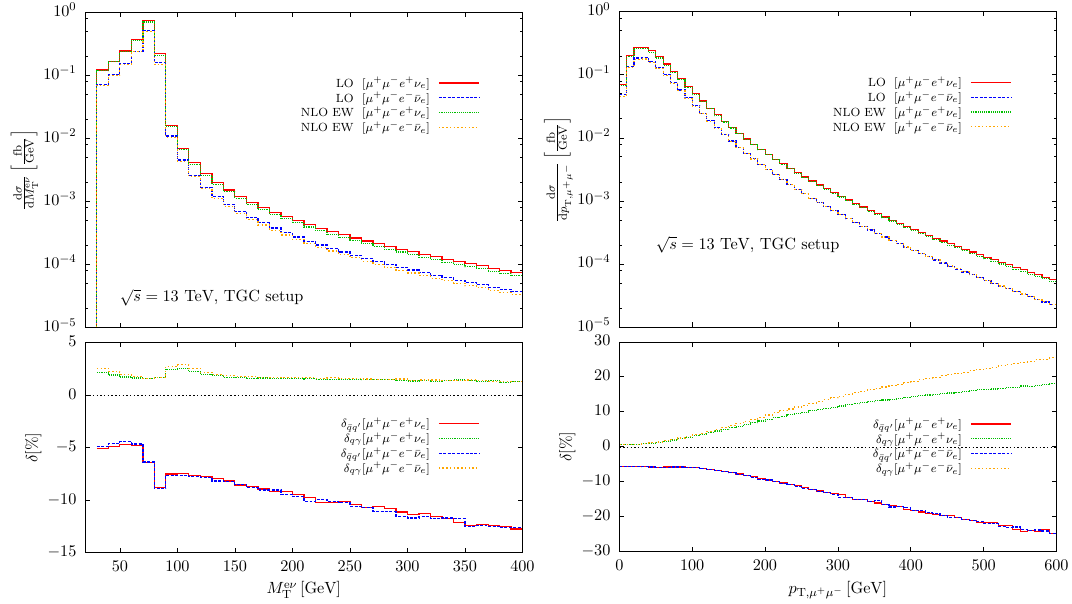
Figure 5 . Distribution in the transverse mass of the reconstructed W boson (left panel) and in the transverse momentum of the µ + µ − pair (right panel) in the TGC